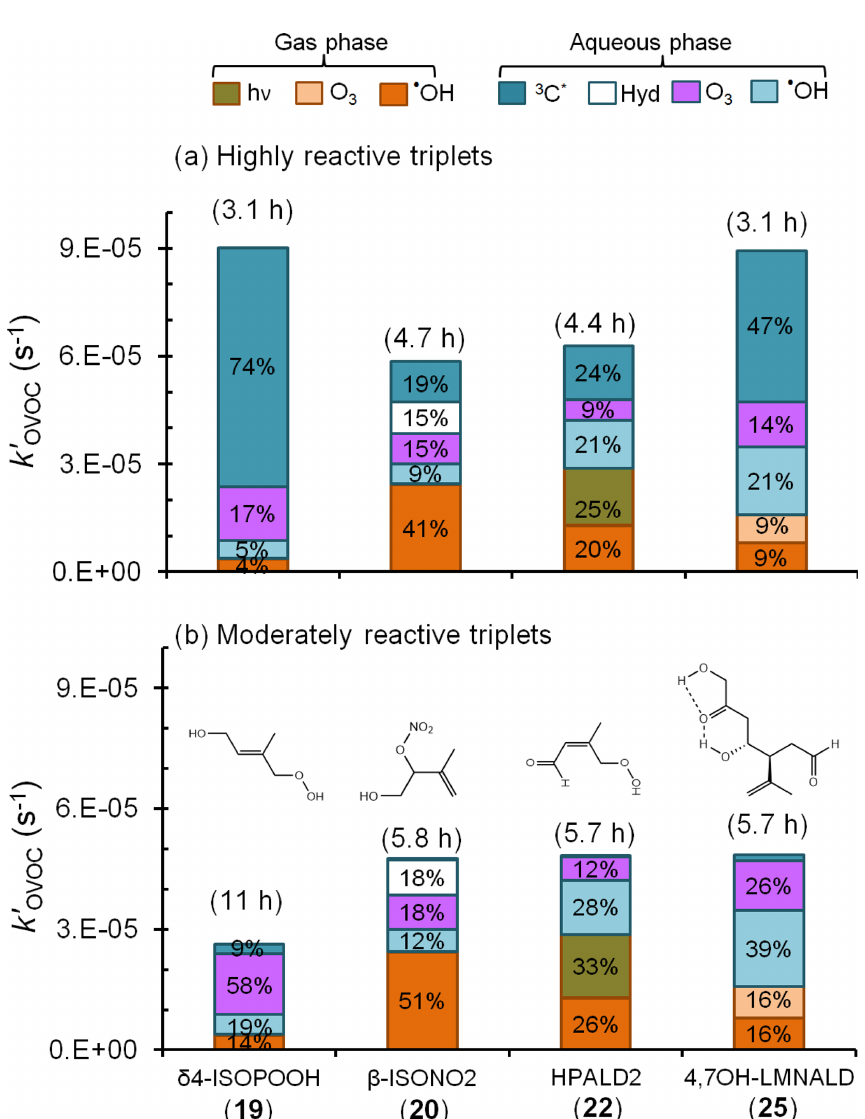
Figure 6. Estimated pseudo-first-order loss rate constants and corresponding lifetimes (in parentheses) for representative isoprene- and limonene-derived oxidation products in a foggy atmosphere (Tables S5–S7). Colors and data labels indicate the percentage of OVOC lost via each gas and aqueous pathway, including direct photoreaction (h ν ) and hydrolysis (Hyd); pathways contributing less than 4% are not labeled. Panel (a) is a likely upper bound for the triplet contributions to OVOC loss in which we assume that all fog triplets are highly reactive, like benzophenone. Panel (b) shows the more likely contribution from triplets, assuming moderately reactive triplets that are more representative of the average measured in fog waters and aqueous particle extracts (Kaur et al., 2018; Kaur and Anastasio, 2018) (Tables